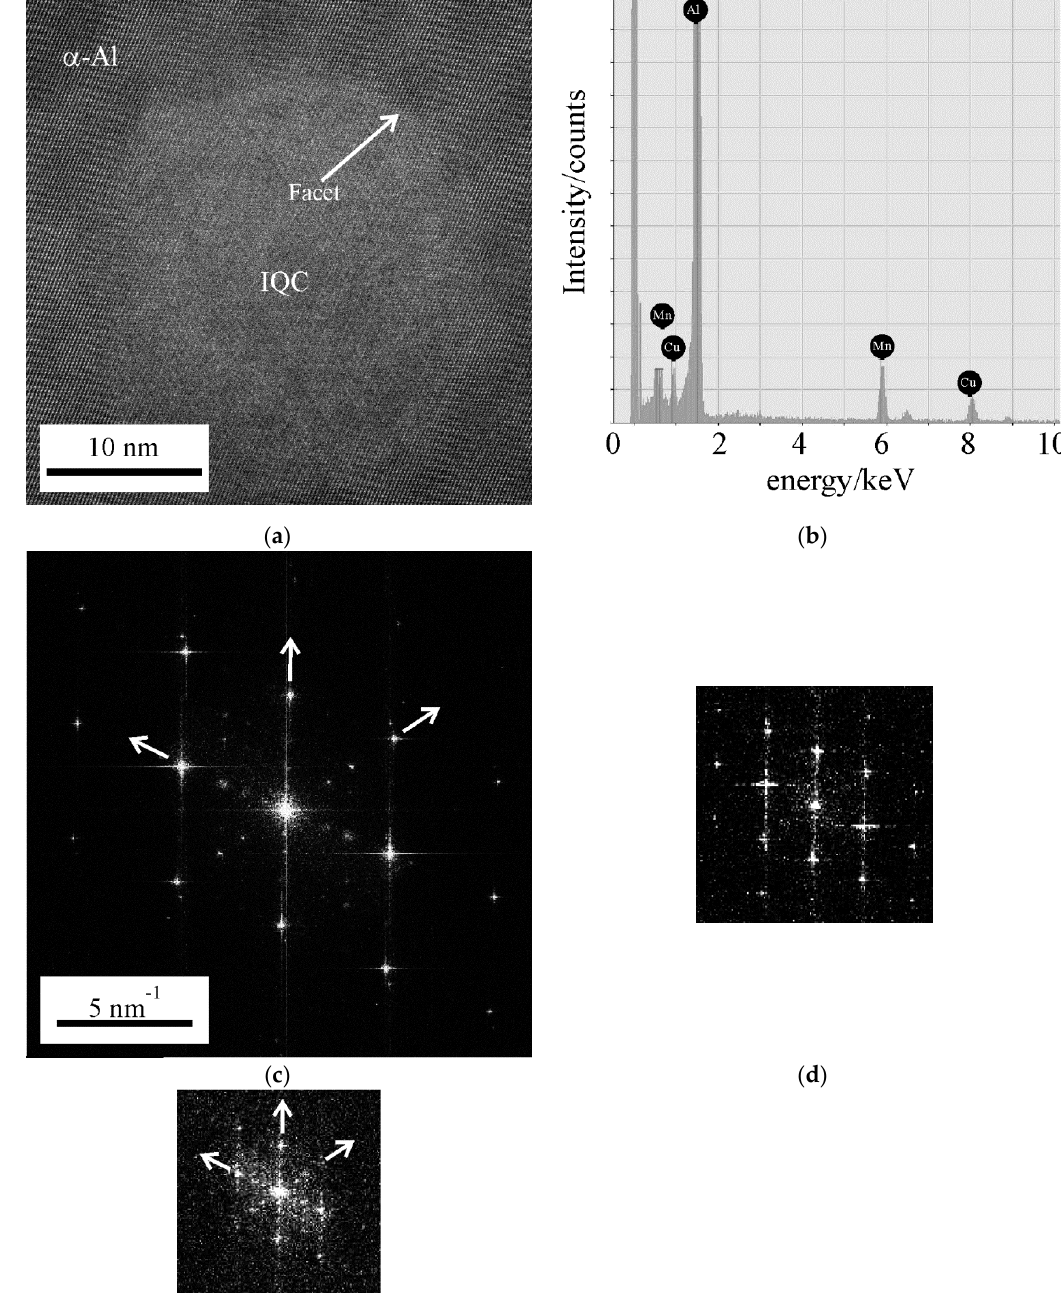
Figure 7. An icosahedral quasicrystalline (IQC) precipitate in Al 95.4 Mn 1.8 Cu 1.6 Be 1.2 after ageing at 400 °C for 1 h. ( a ) A high-resolution scanning transmission electron image, ( b ) an EDS spectrum of the IQC particle, ( c ) Fast Fourier transform (FFT) of all area, ( d ) FFT of Al-rich matrix, with the zone axis [111], ( e ) FFT of the IQC particle, with the threefold zone axis